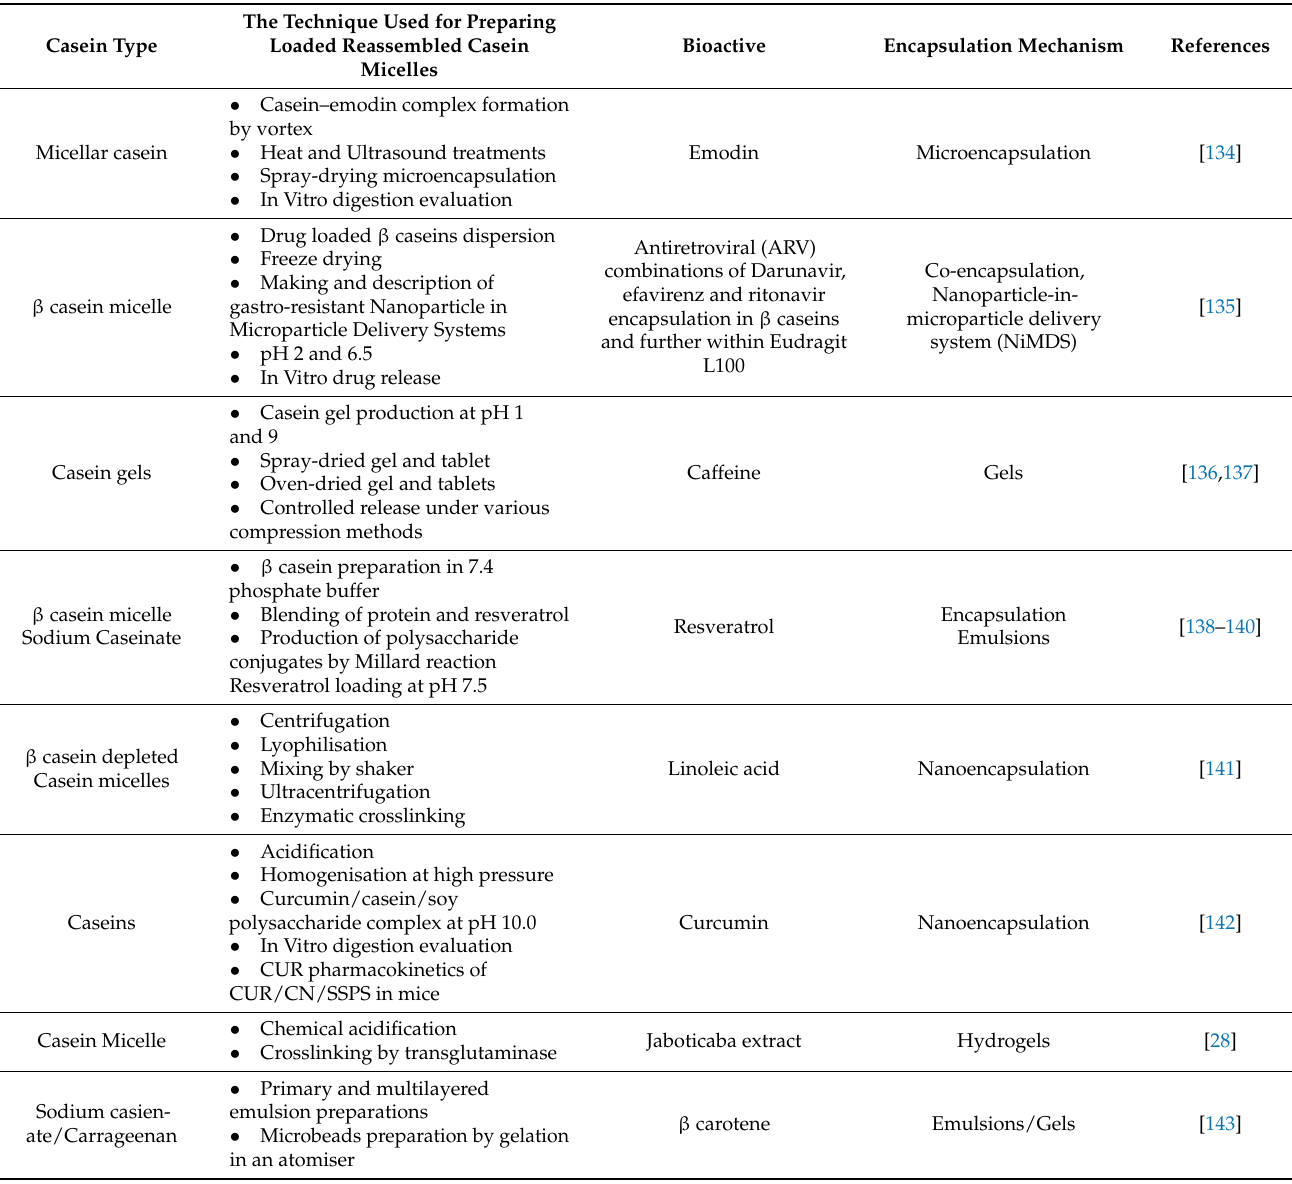
Table 3. Casein Micelles-Based Capsules and Hydrogels in Delivering Food